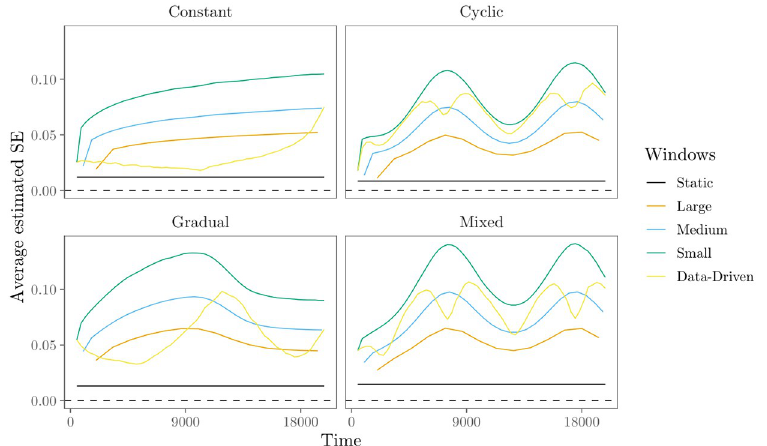
Fig 6. Average estimated standard error (SE) for the ‘transitivity’ effect in the evaluation of the moving window REM. Panels refer to the four time-varying effect scenarios. Solid lines represent the average estimated SE of the parameter estimates over time, with colors representing estimation with large (4000 t ), medium (2000 t ), small (1000 t ) and data-based window widths.